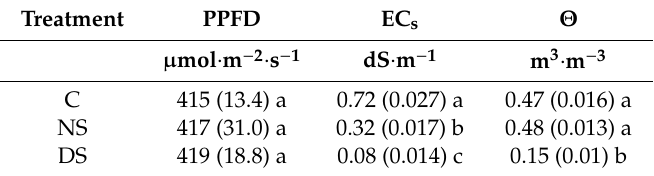
Table 1. Photosynthetic photon flux density (PPFD), substrate electrical conductivity (EC s ) and volumetric water content ( θ ) maintained in the control (C), nitrogen stress (NS), and drought stress (DS) treatments in the main experiment. Treatment means followed by the same letter are not statistically di ff erent ( p ≤ 0.05). Values in parenthesis indicate standard error of mean.